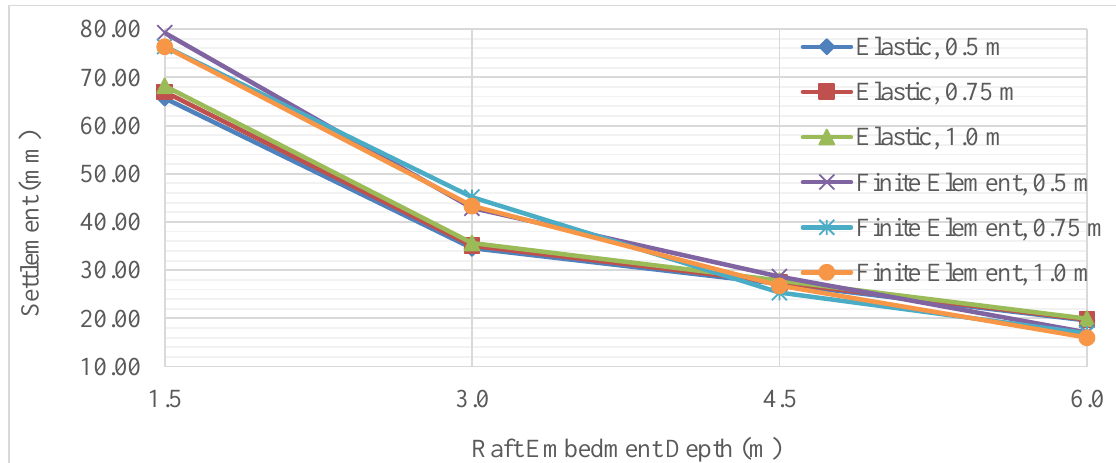
Fig. 13. Settlement versus depth showing the effect of raft thickness for 300 kN/m 2 .